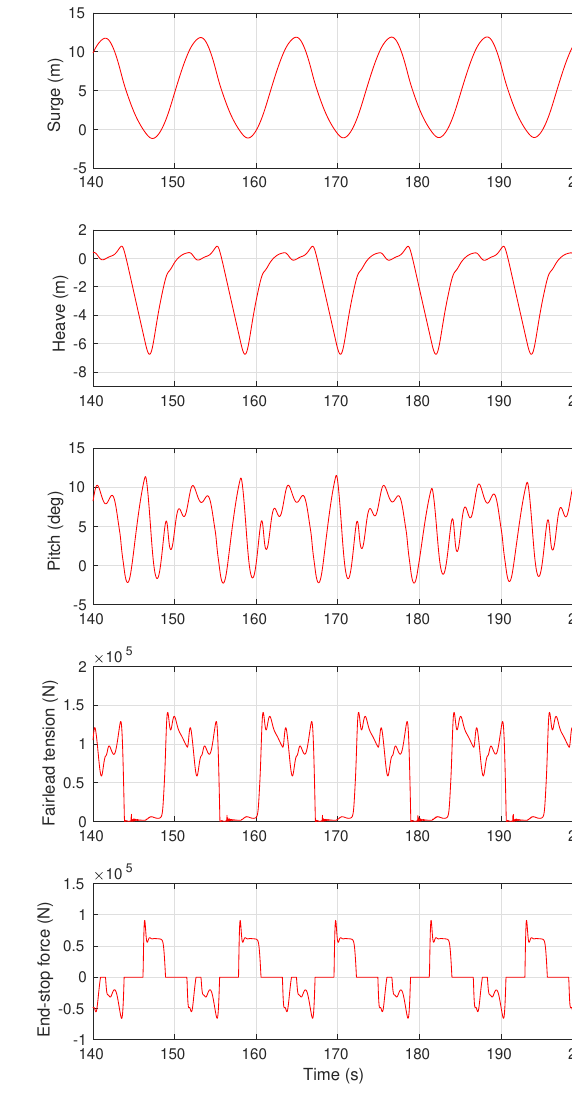
(b) ERW2: T = 11 . 7 s and H = 13 . 3 m.